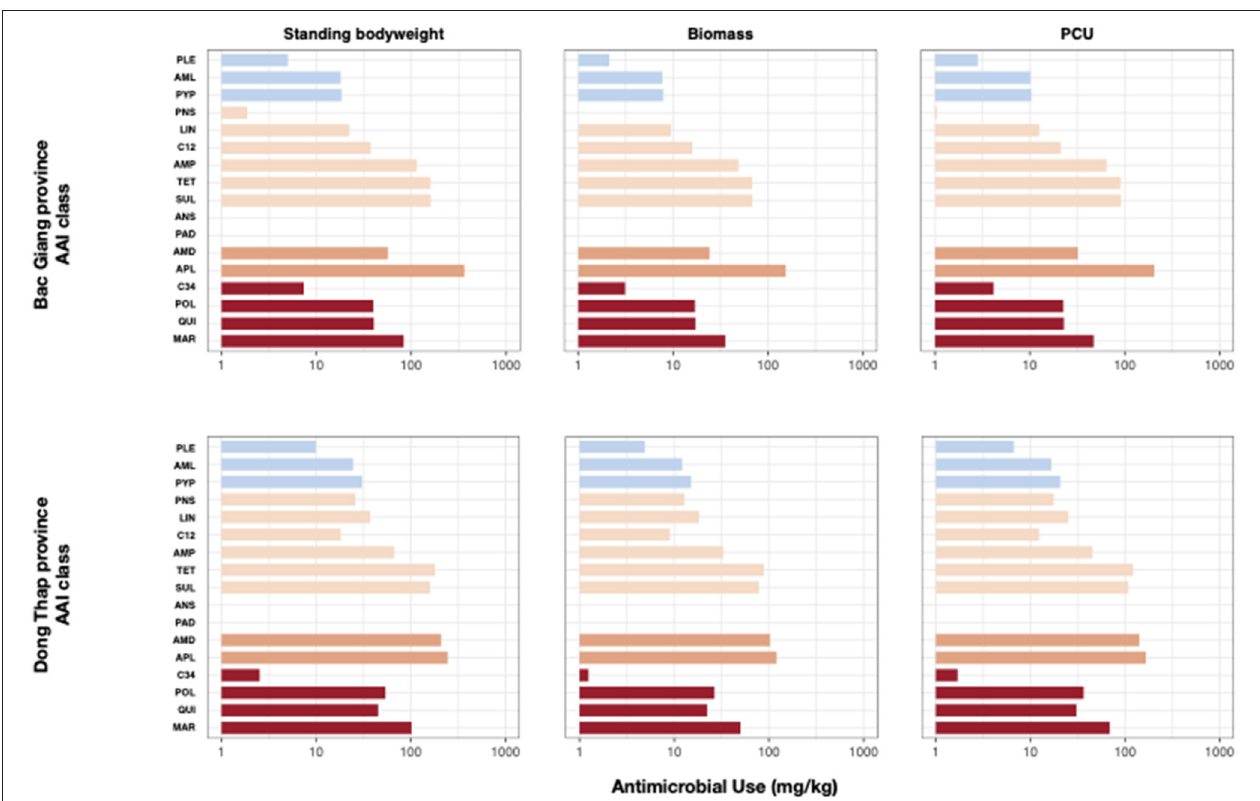
FIGURE 3 | Comparison of AMU sales following antimicrobial classes by three metrics (Standing bodyweight, Bioomas, and PCU) in the two study provinces (Bac Giang and Dong Thap). x-axis, estimation of annual AMU sales (mg/kg) by three different metrics; y-axis, the surveyed districts in Bac Giang and Dong Thap provinces; Blue, important antimicrobial group; Light Brown, highly important antimicrobial group; Brown, high priority antimicrobial group; Red, highest priority antimicrobial group; PCU, Population Correction Unit; AAI, active antimicrobial ingredient; PLE, pleuromutilins; AML, aminocyclitols; PYP, polypeptides; PNS, penicillins (narrow spectrum); lin, lincosamides; C12, 1st-2nd generation cephalosporins; AMP, amphenicols; TET, tetracyclines; SUL, sulphonamides; ANS, ansamycins; PAD, phosphonic acid derivatives; AMD, aminoglycoside; APL, aminopenicillins; C34, 3th − 4th generation cephalosporins; POL, polymyxins; QUI, quinolone; MAR,